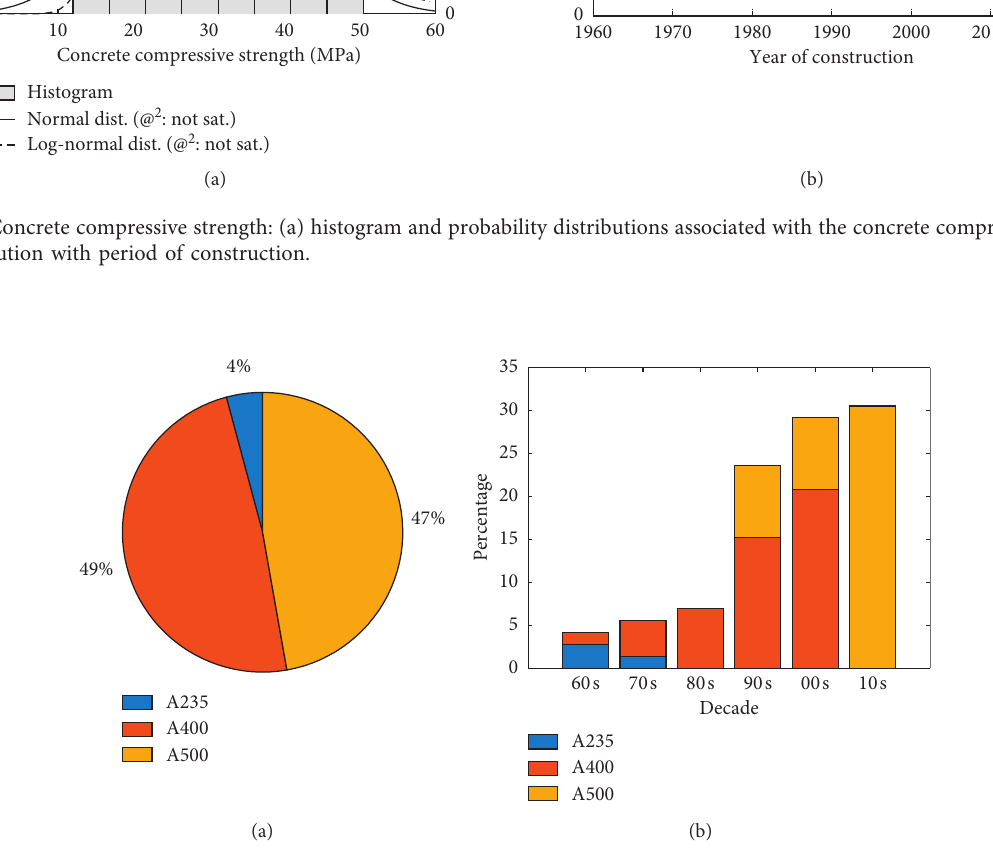
Figure 17: (a) Percentage and (b) distribution of reinforcement grade by year of